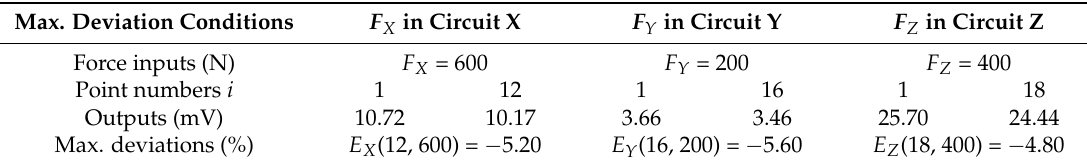
Table 2. Maximal deviations of desired signals in different positions.